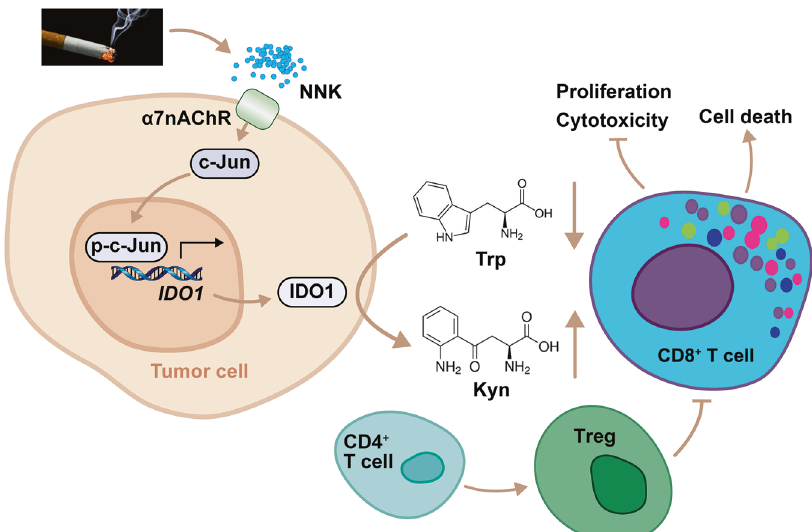
Fig. 7 Mechanisms of action of tobacco smoke in promotion of tryptophan catabolism and immunosuppressive microenvironment. Tobacco smoke activates c-Jun through NNK- α 7nAChR axis, leading to upregulation of IDO1 in tumor cells. IDO1 triggers catabolism of tryptophan and production of kynurenine, resulting in suppression of CD8 + T cells and accumulation of Tregs. These effects promote environmental lung